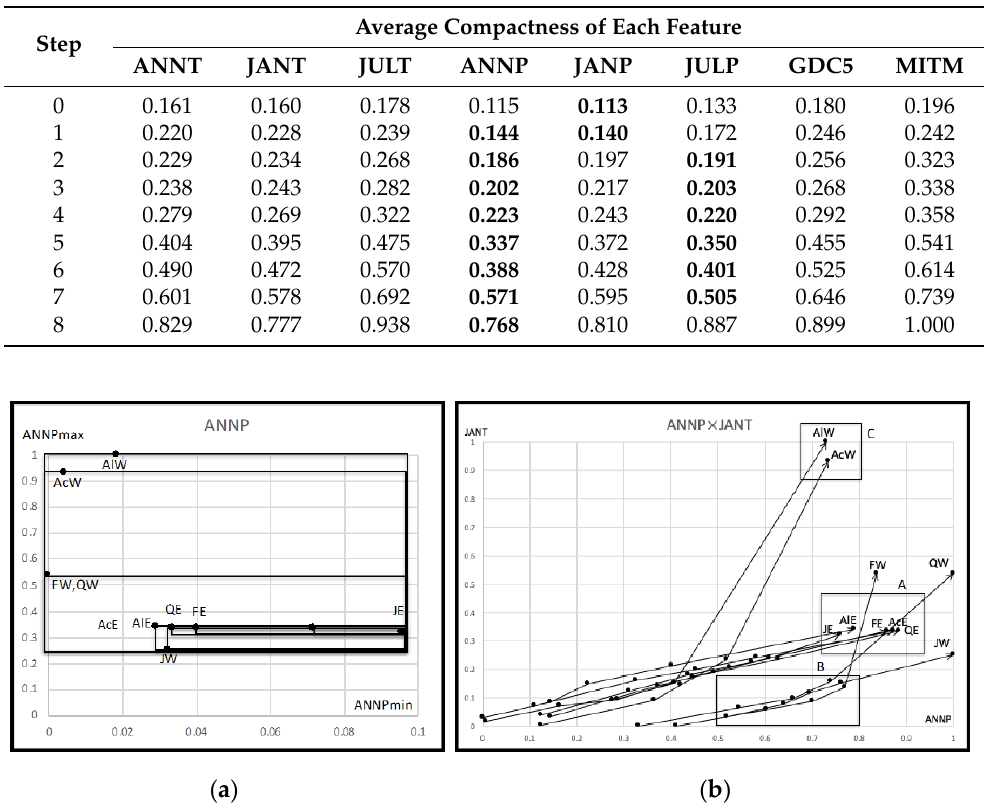
Figure 18. Scatter diagrams for the selected informative